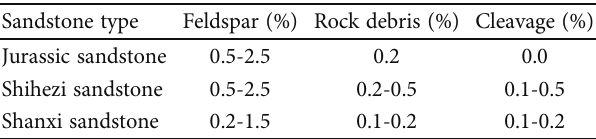
Figure 4: Pore types in the deep mine sandstone. (a) Jurassic sandstone, 1047.37m, Z23 (-). (b) Permian sandstone, 1068.83m, X9 (-). (c) Permian sandstone, S12 (-), 920.28m. (d) Permian sandstone, 1007.22m, S18 (-). (e) Permian sandstone, 920.98m, S12 (-). (f) Permian sandstone, 1012.84m, A1 (-). (g) Permian sandstone, 911.46m, S10 (-). (h) Permian sandstone 1068.83 m, X9, SEM. (i) Jurassic sandstone, 1023.26m, Z9 (-). (j) Permian sandstone, 1153.04 m, T13 (-). Table 4: Types and contents of intragranular pores in deep mine sandstone ∗